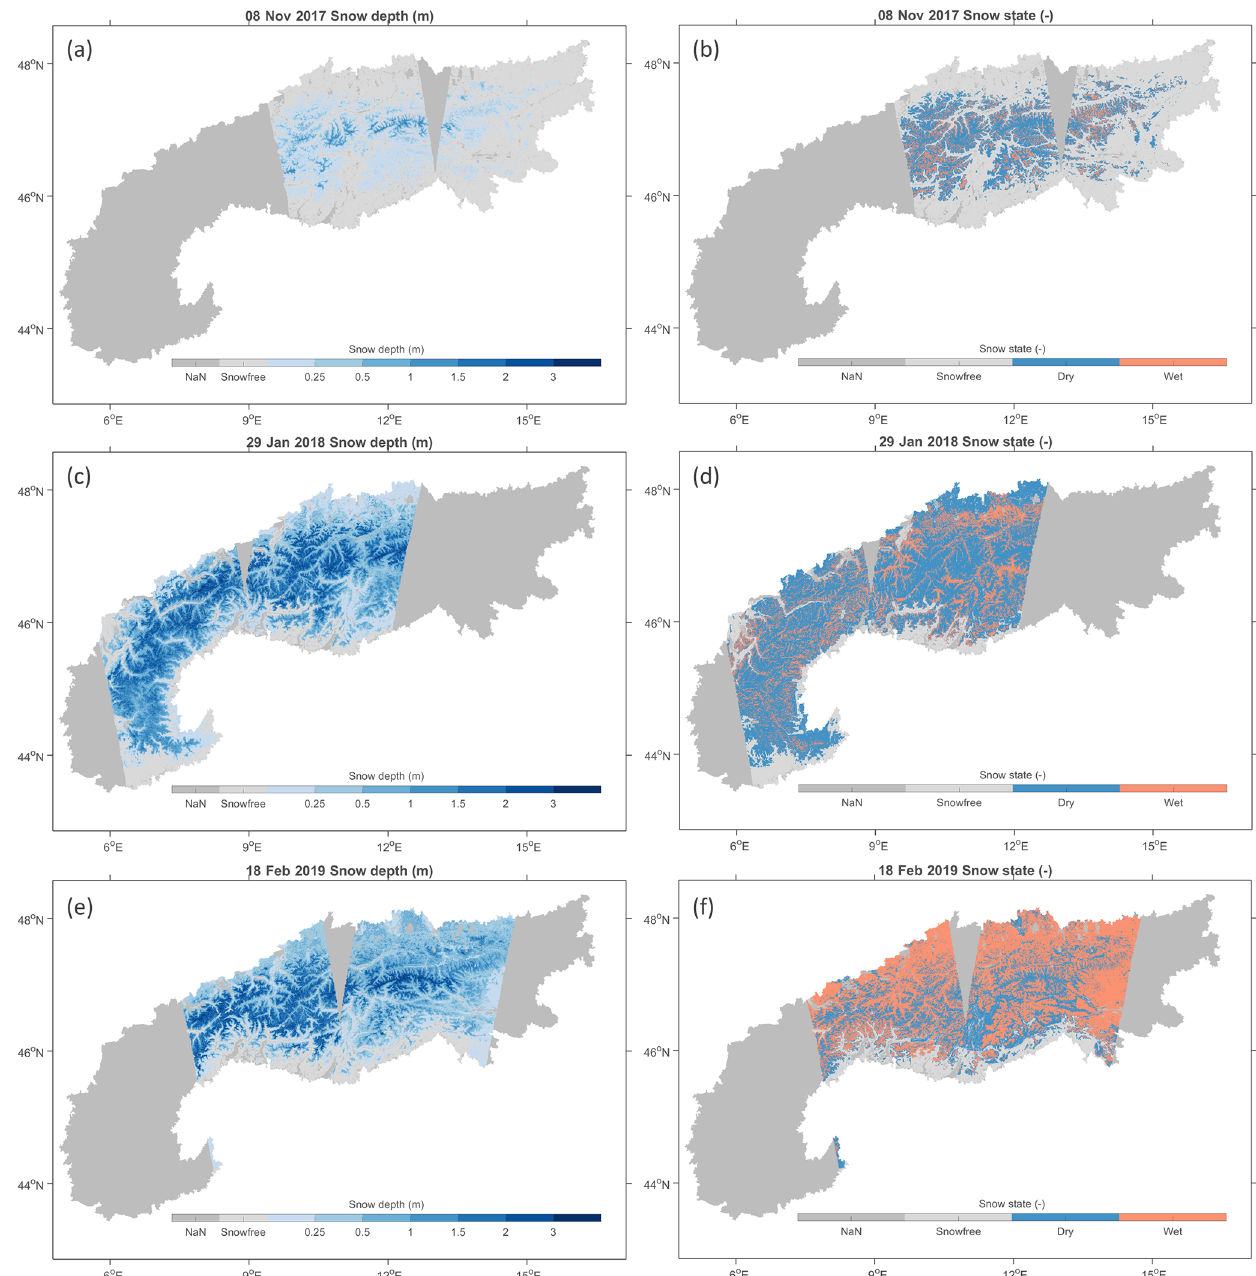
Figure 10. S1 snow depth (m) and snow state (dry or wet) retrievals at 500m spatial resolution over the Alps, for (a, b) 8 November 2017, (c, d) 29 January 2018, and (e, f) 18 February